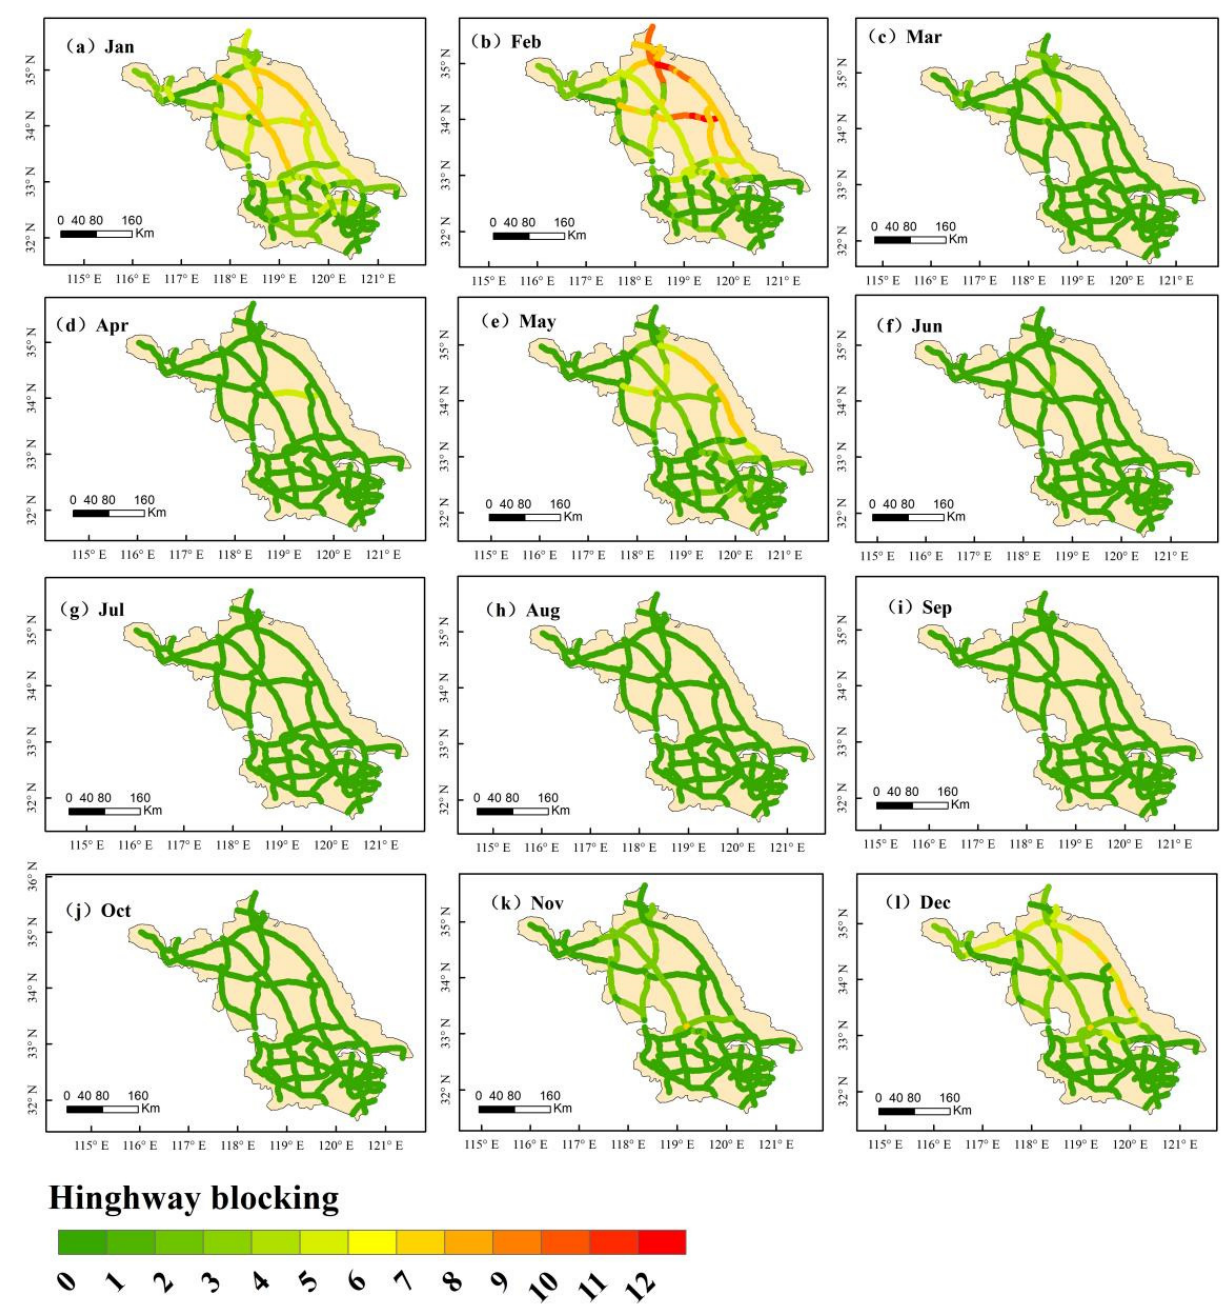
Figure 5. Annual variation of highway blockage distribution in Jiangsu Province in 2020.